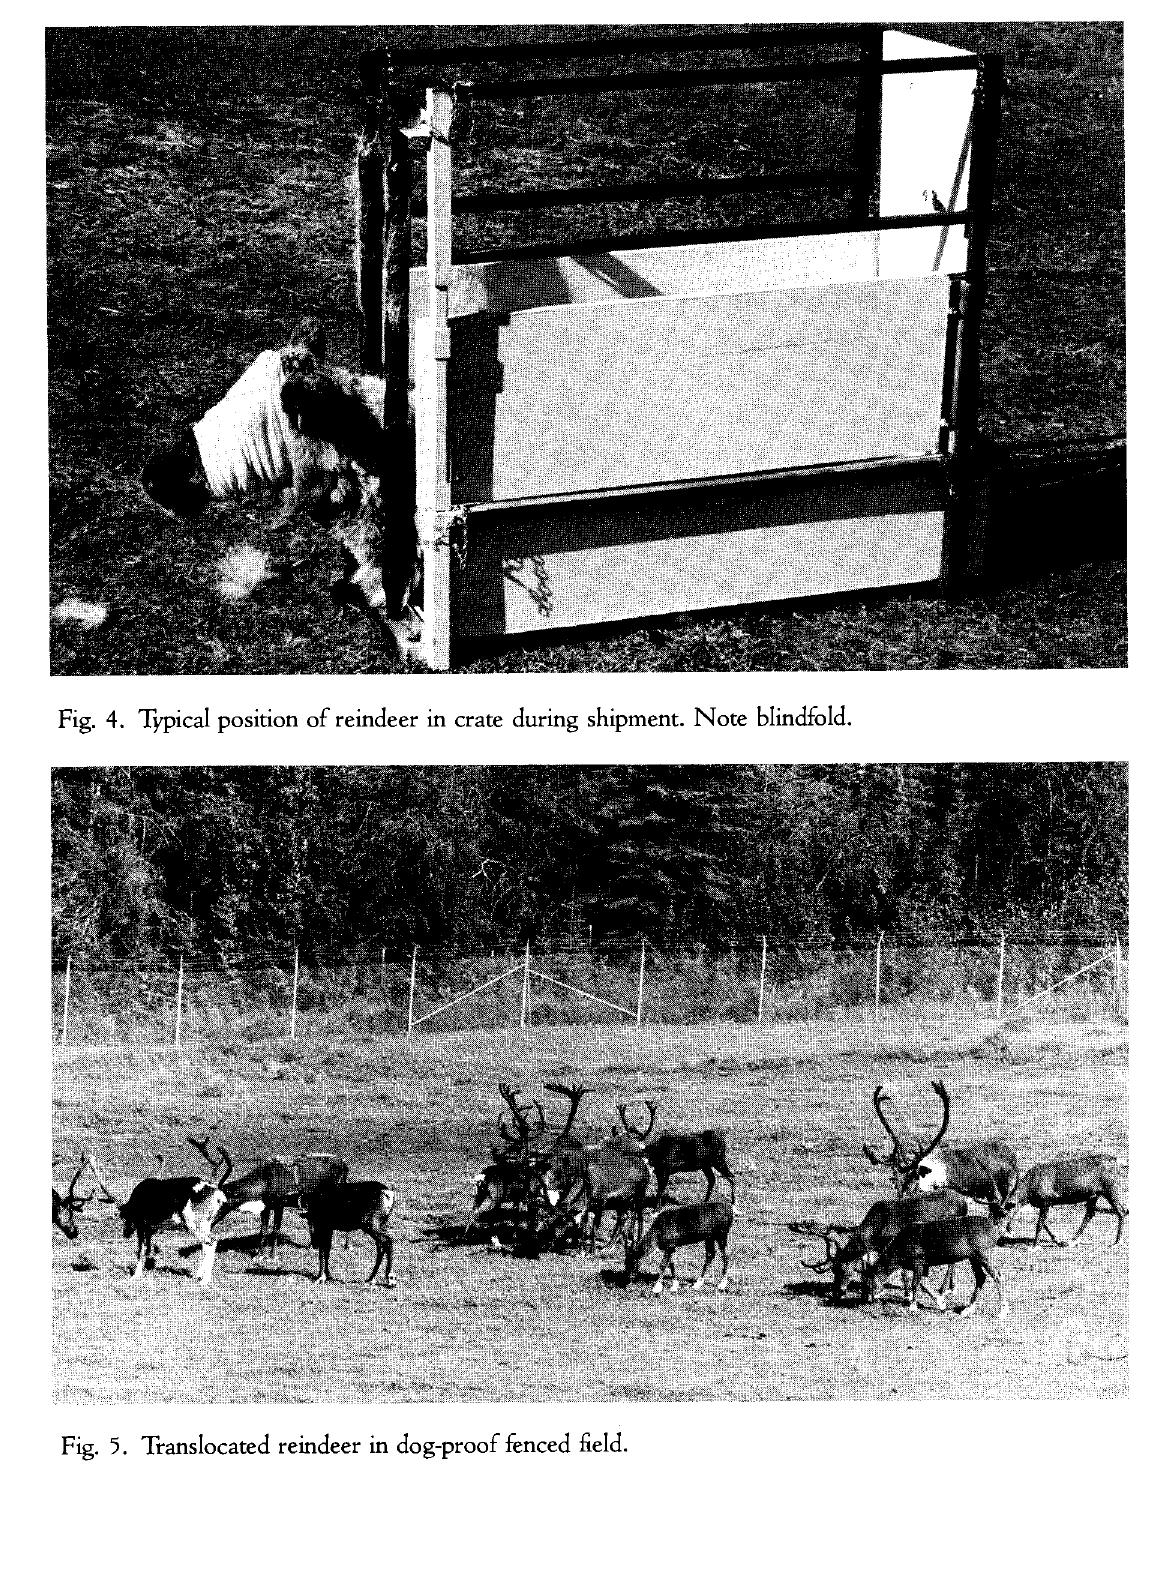
Fig. 5. Translocated reindeer in dog-proof fenced